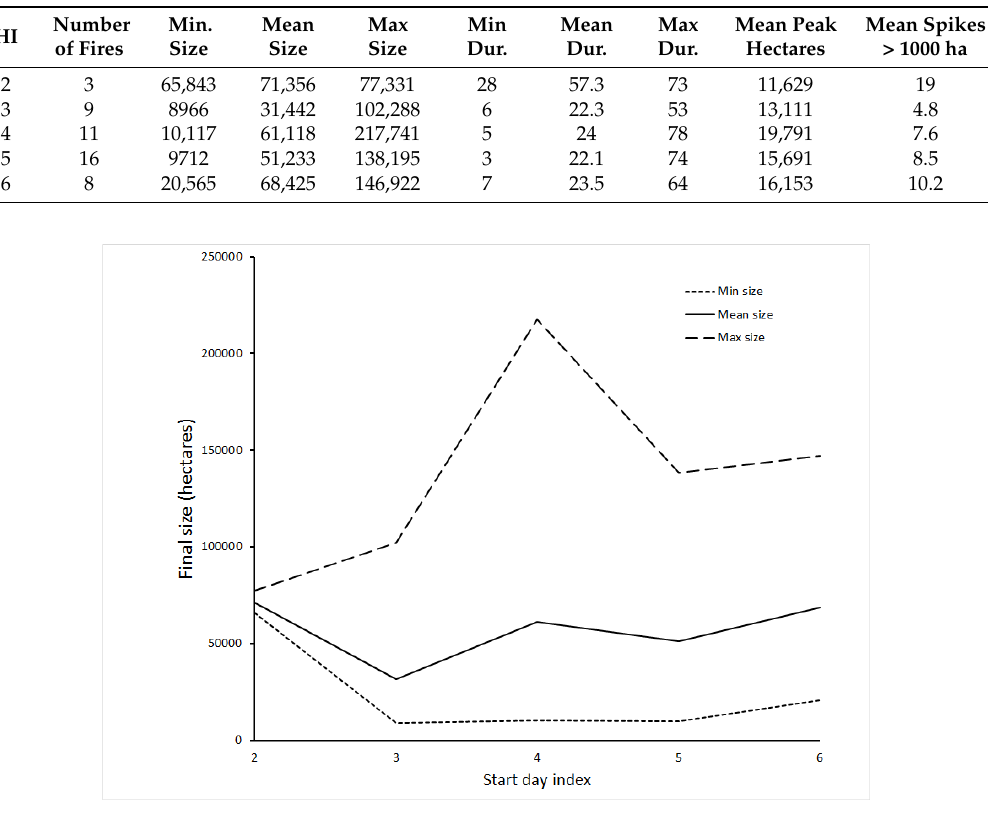
Figure 2. Final size of fires based on start-day Haines Index value.